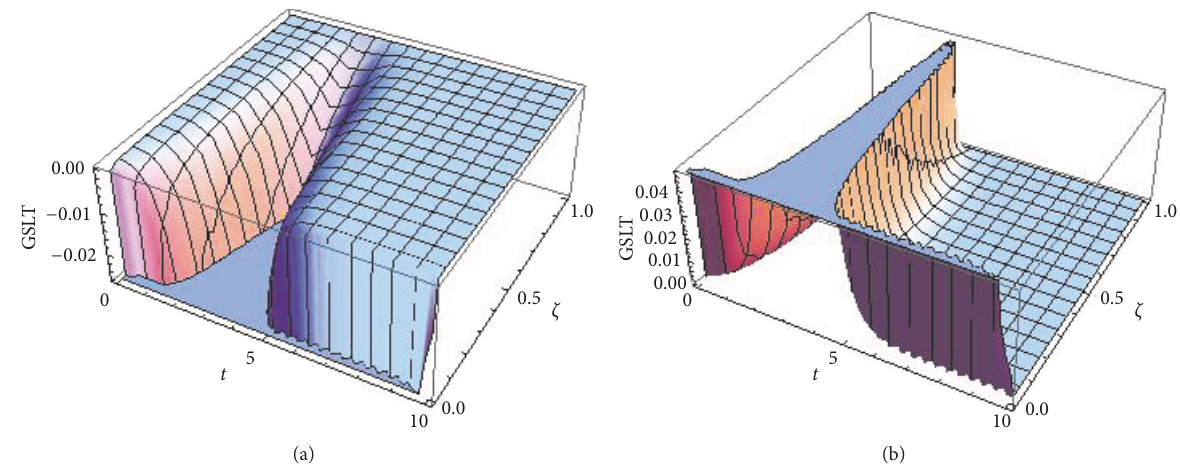
Figure 2: Validity of GSLT for the model (44). (a) is for 𝑐 1 = −1 with 𝑐 2 = 1 and (b) for 𝑐 1 = 𝑐 2 = −1 .